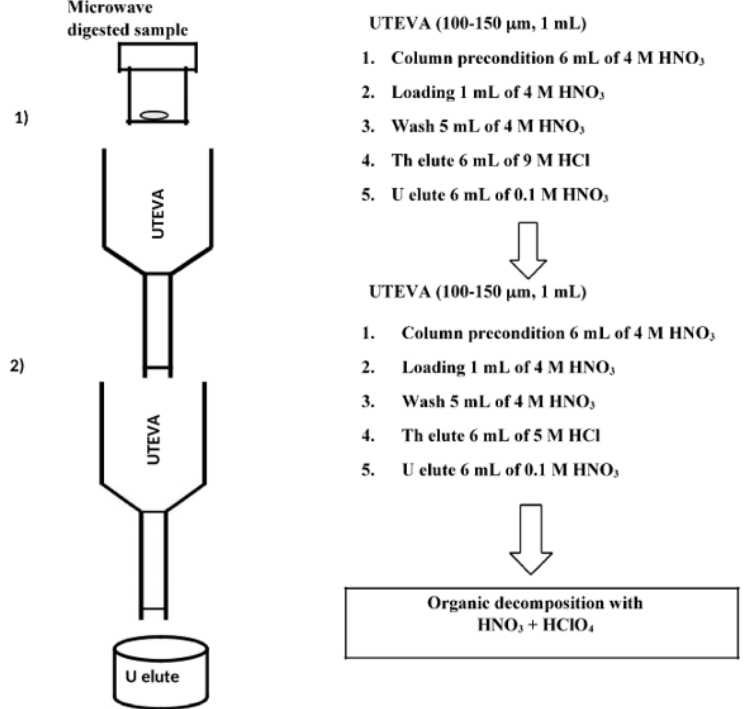
Figure 1. The chemical separation scheme of U using two UTEVA resin column.